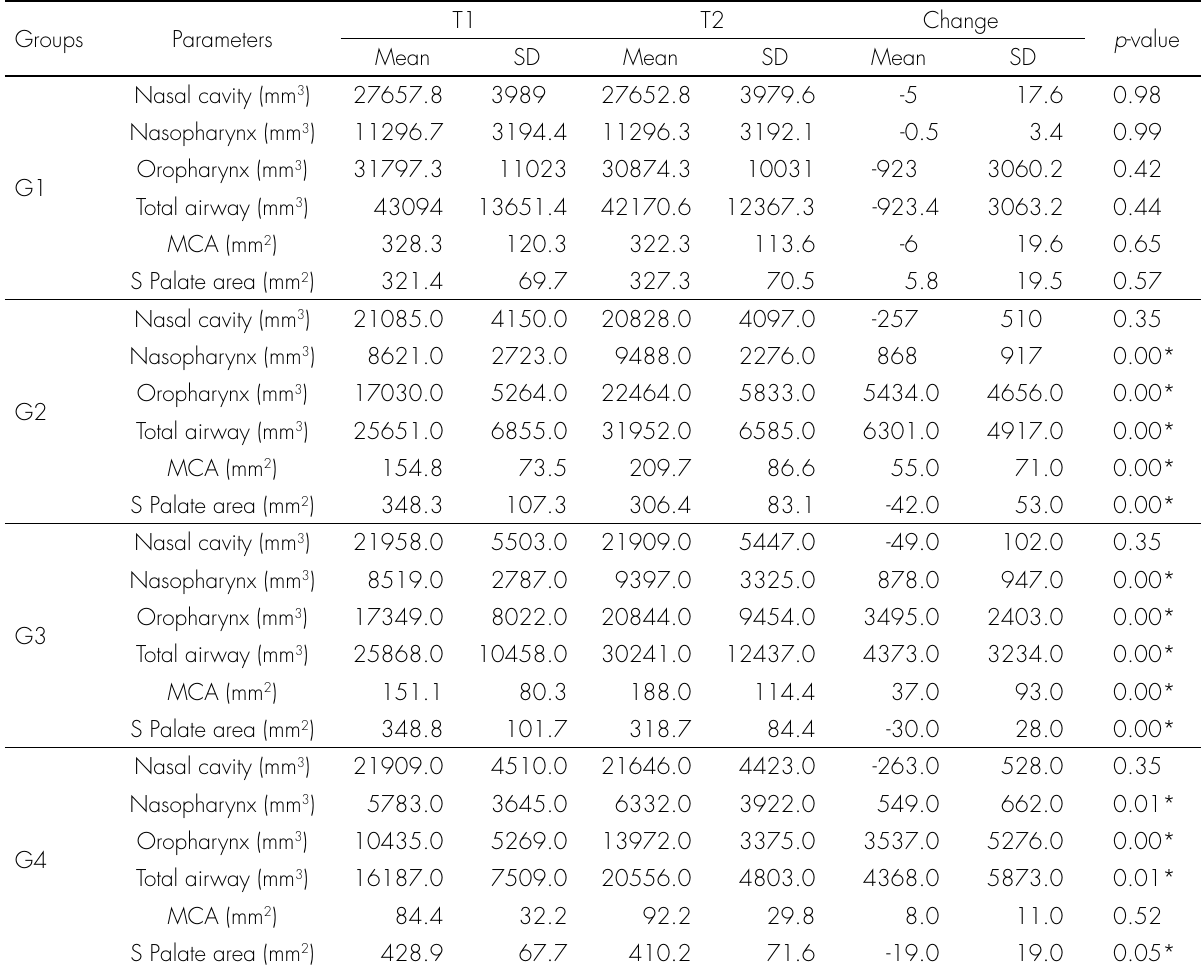
Table IV. Comparison of airway volumes and soft palate area between T1 and